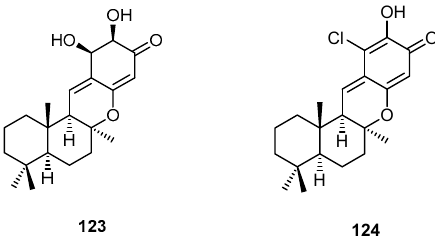
Figure 32. Chemical structures of puupehanol ( 123 ) and chloropuupehenone ( 124 ).